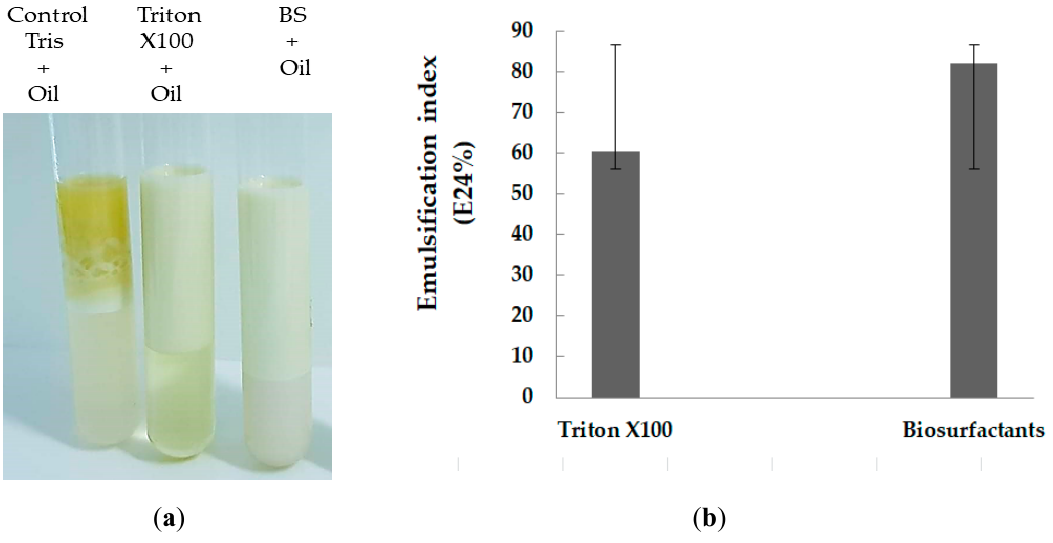
Figure 4. Emulsification index (E24) observed in the presence of BS. The cell-free supernatant of Pantoea alhagi strain Zcb15 as compared to the presence of Triton X-100 as positive control and Tris base buffer as negative control ( a ) and the E24 index of the BS secretion by the strain Zcb15 expressed in a percentage as compared to the positive control (Triton X-100) ( b ).